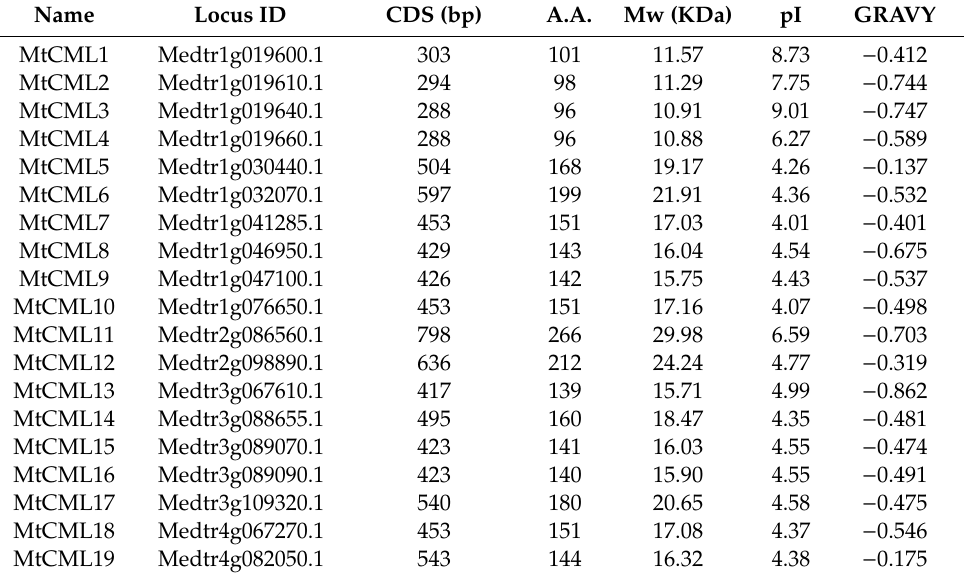
Table 1. Information on MtCML